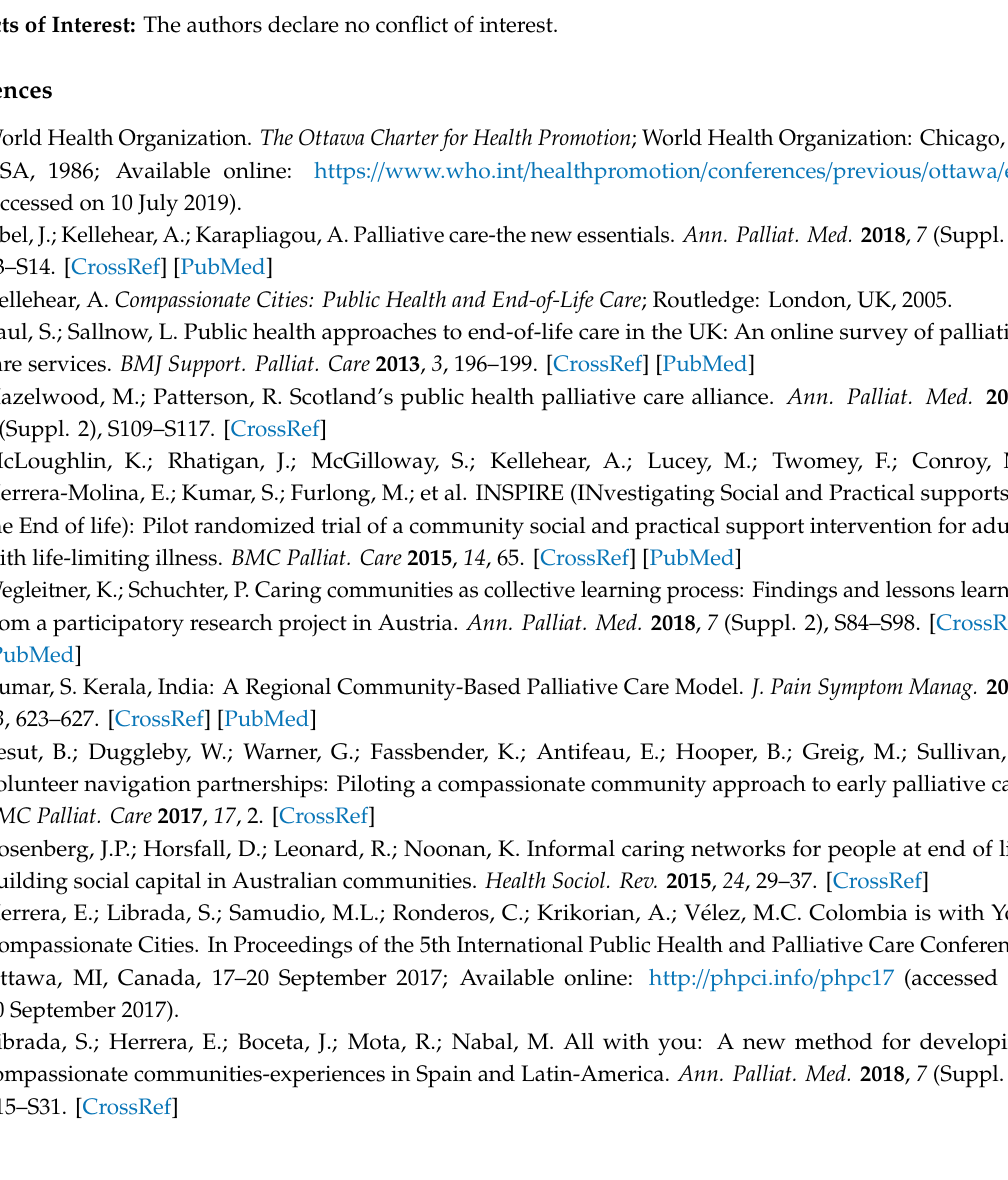
Table S1: Characteristics of included